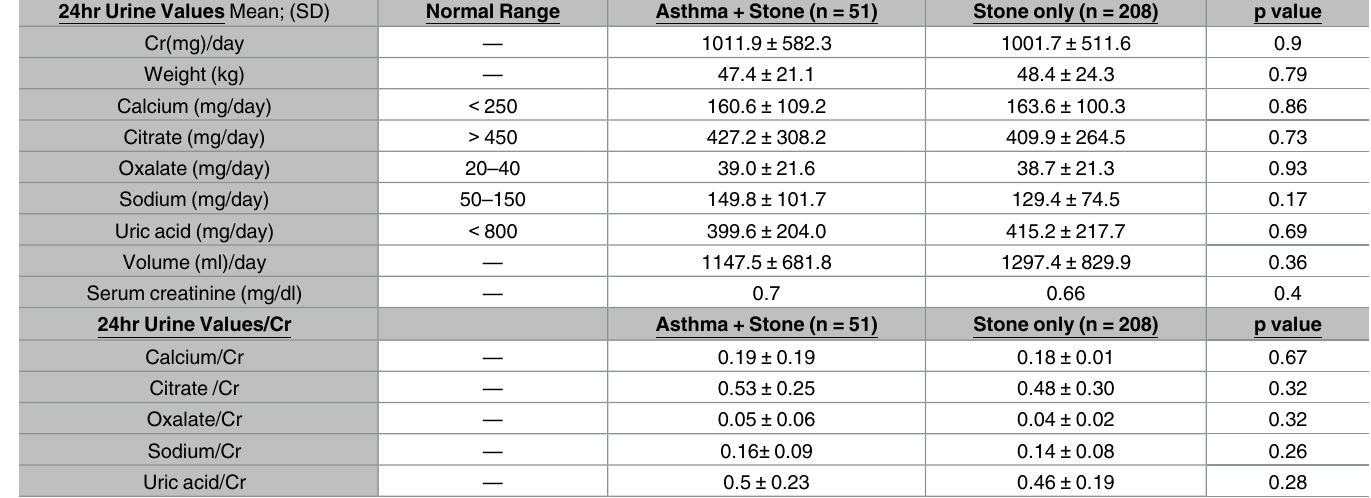
Table 4. 24 hour urine comparison between asthma patients with stone and those with stone only diagnosis (Cr = Creatinine, SD = Standard deviation). 24hr Urine Values Mean;